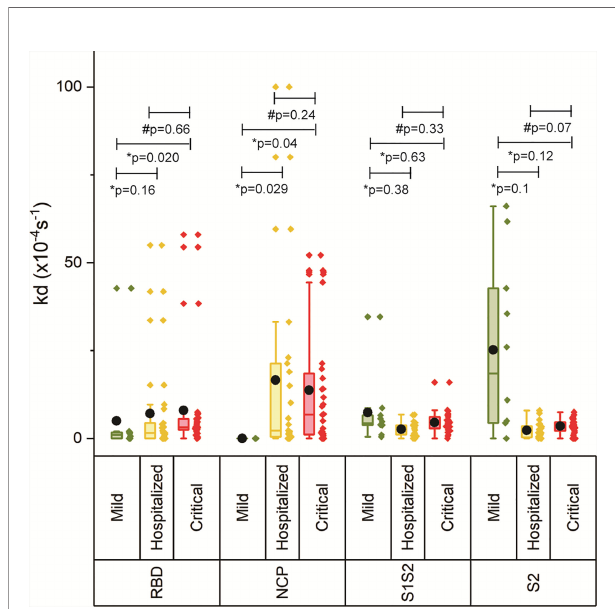
FIGURE 3 | Binding strength measurements of four antigens of SARS-CoV2. The off-rate of the antibodies binding to the four antigens was determined for each severity group. The boxplot represents the median, p25, and p75 values, and the black dot represents the mean SPRi RU value. Comparability of groups was analyzed by Mann – Whitney U test. A Bonferroni – Holm procedure was used to correct for multiple comparisons between groups.